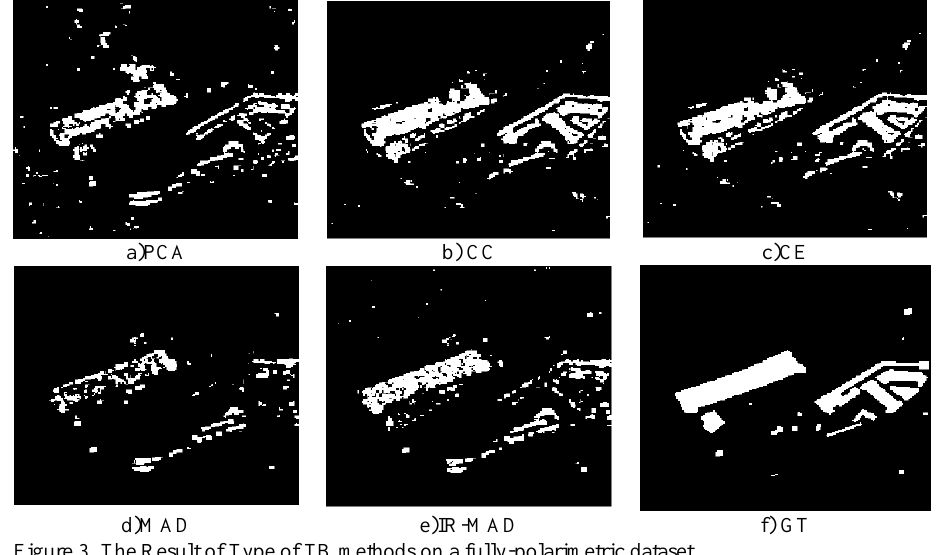
Figure 3. The Result of Type of TB methods on a fully-polarimetric dataset.